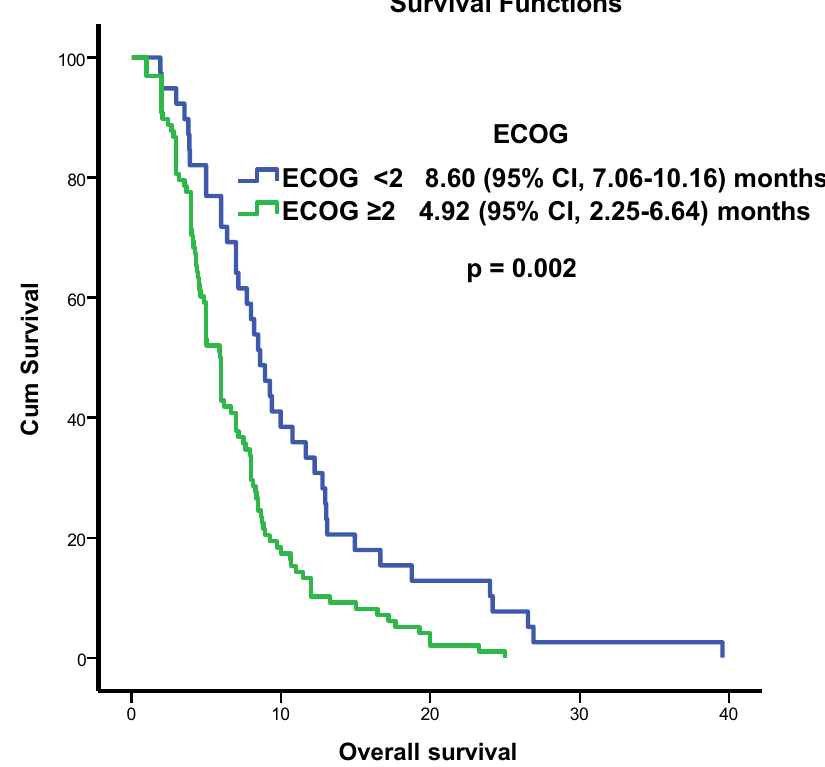
Figure 2. Kaplan–Meier survival curves according to Eastern Cooperative Oncology Group (ECOG) performance score. The overall survival rates were significantly worse in the ECOG performance score ≥ 2 group ( p = 0.002).